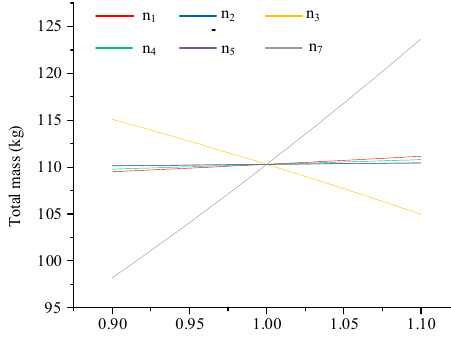
Figure 29. Mass response curve.